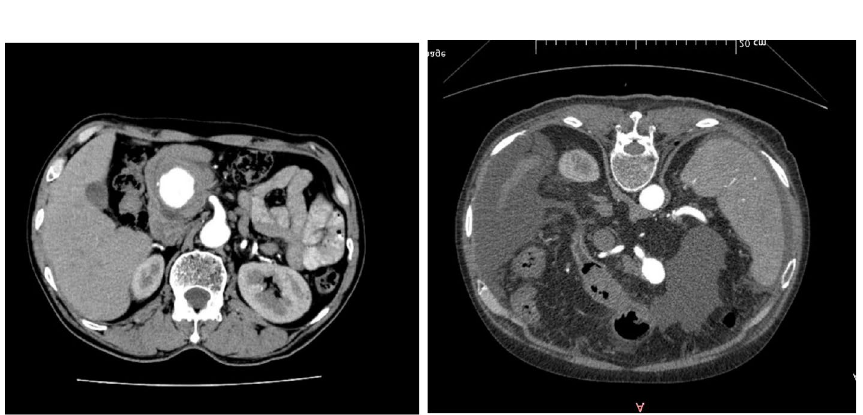
Figure 2. ( A ) Renal artery aneurysm (RAA) arising from a branch of the renal artery. ( B ) Post coil embolization angiogram showing complete exclusion of aneurysm.